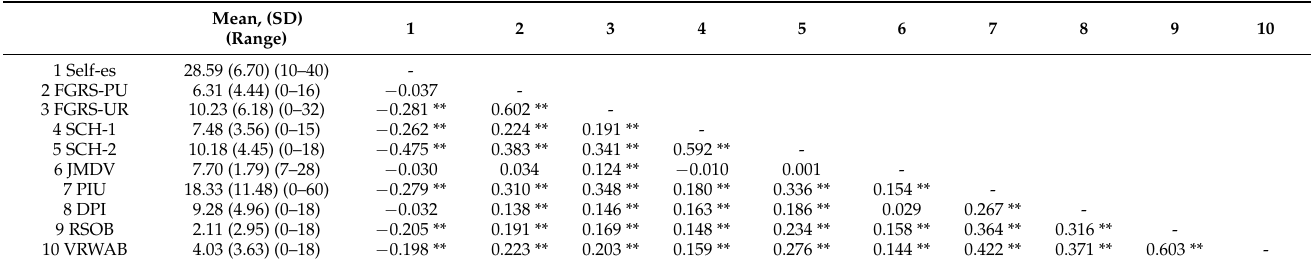
Table 3. Descriptive statistics of covariates and